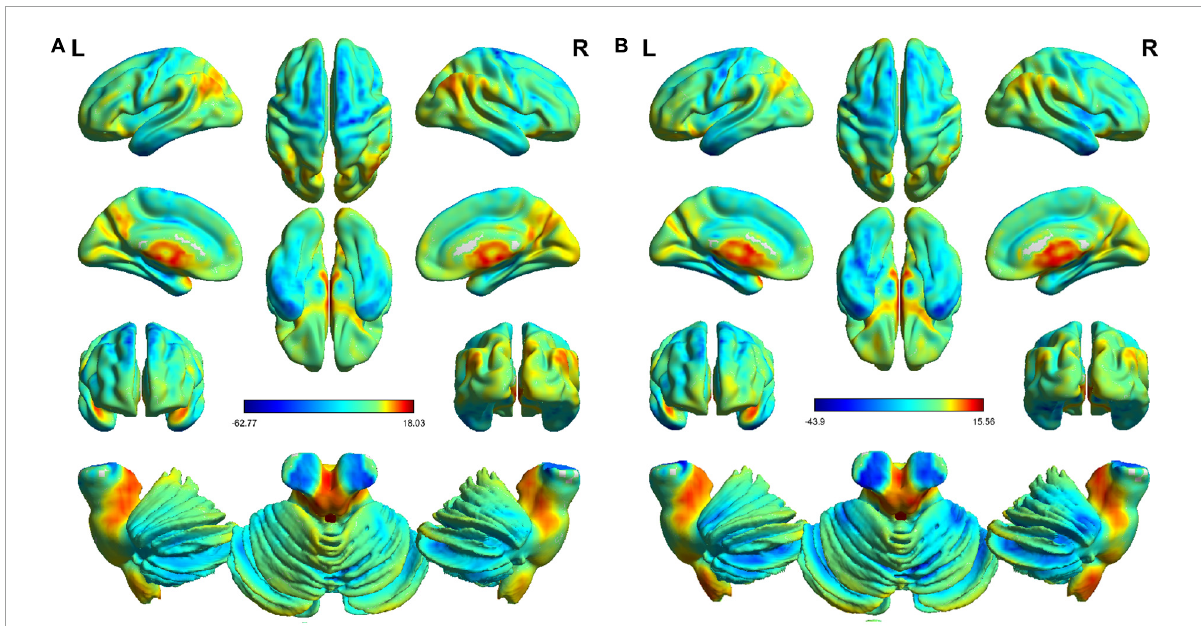
FIGURE1 One-sample t -test ( P < 0.01, FDR corrected) distribution of the results of the classical frequency bands in the HC and OSA groups. Generally speaking, the spatial distribution of the two groups was similar. Panel (A) is the distribution in the HC group. Panel (B) is the distribution in the OSA